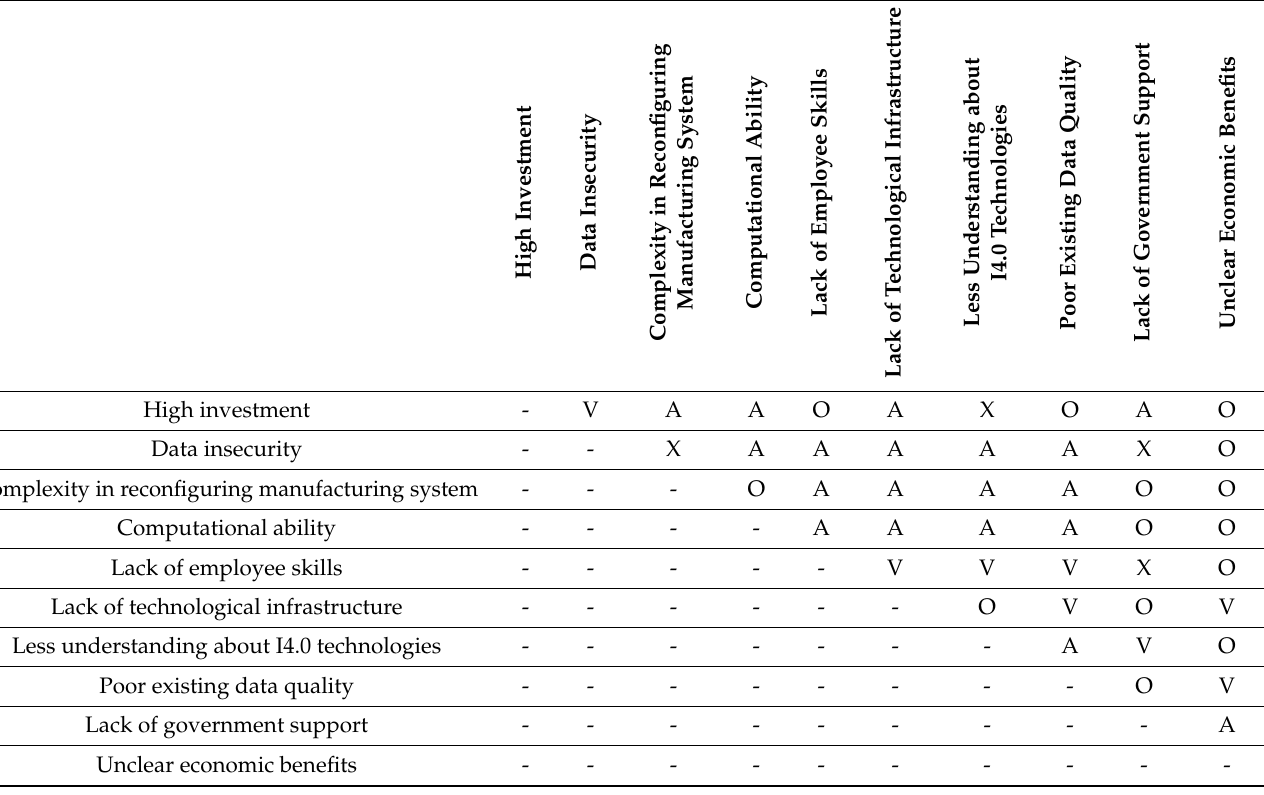
Table 2. Structural self-interaction matrix for I4.0 challenges.